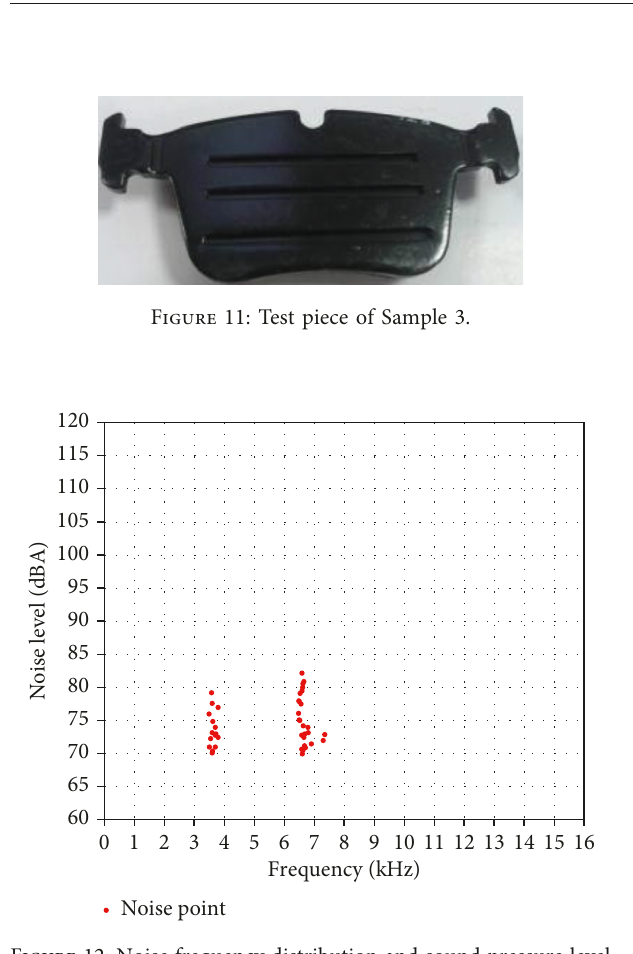
Figure 12: Noise frequency distribution and sound pressure level of the test piece.